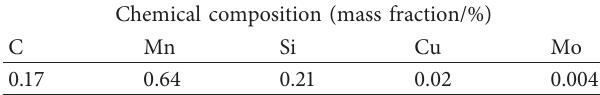
Table 1: Chemical composition of grade-A ship steel. Chemical composition (mass